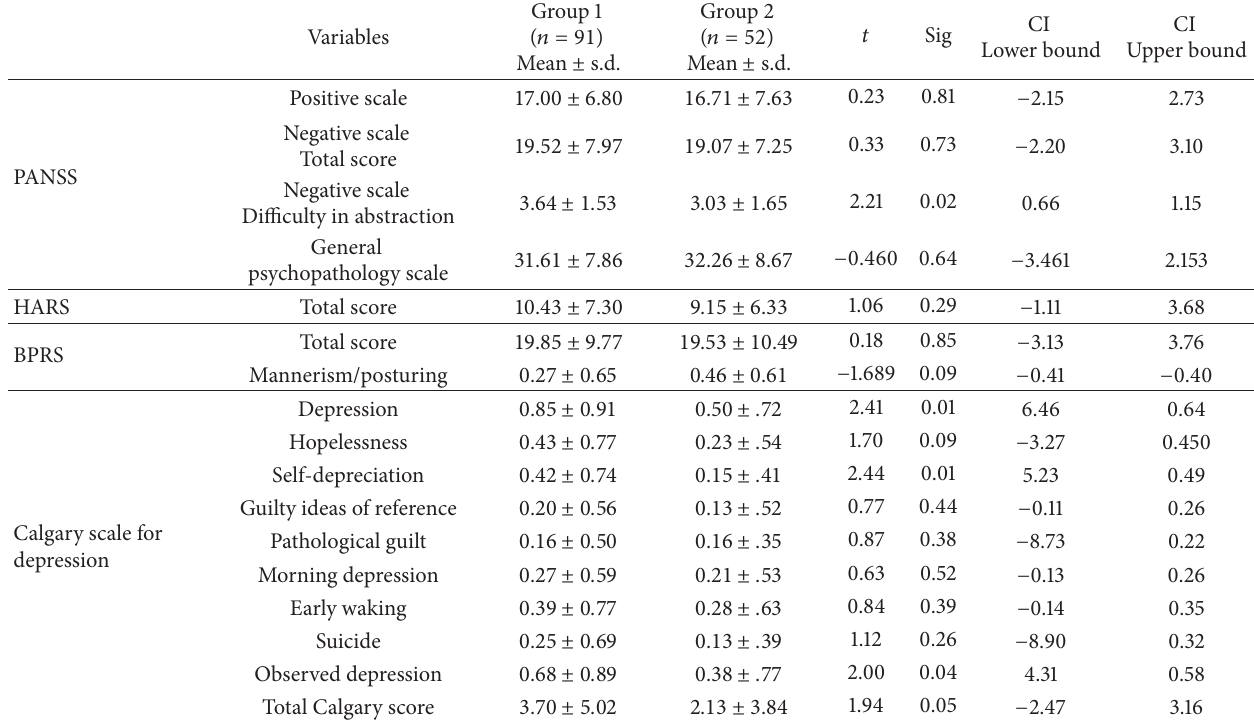
Table 3: PANSS, HARS, BPRS, and Calgary scale for depression scores at 3 weeks in schizophrenia patients with substance use disorder (Group 1) and without substance use disorder (Group